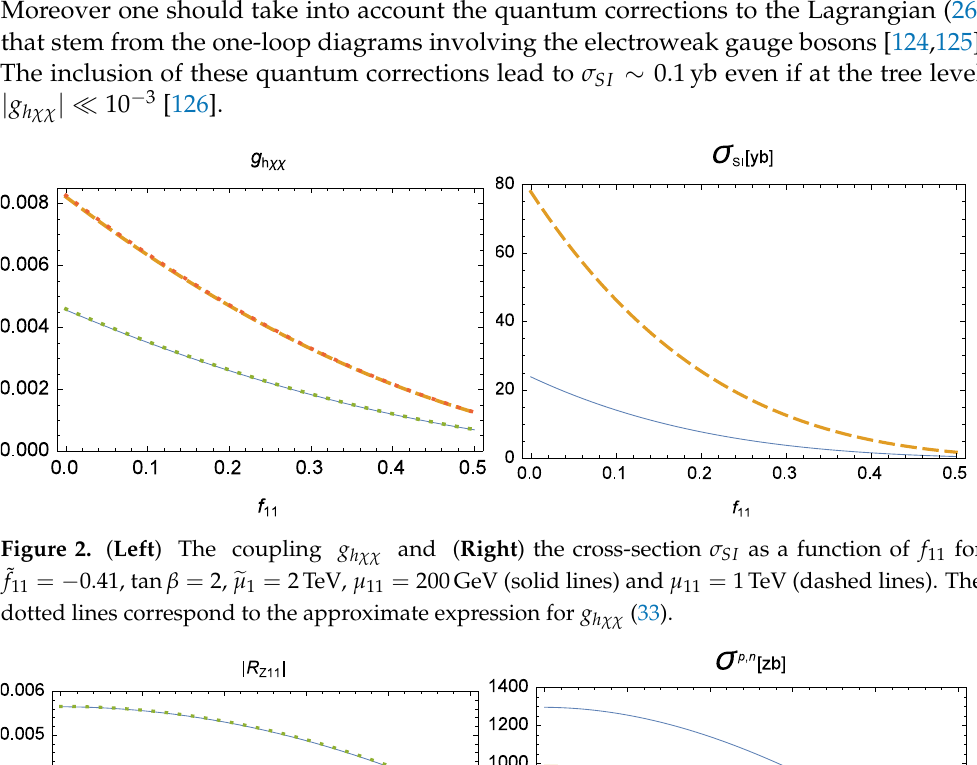
= 1TeV (dashed lines). The 11